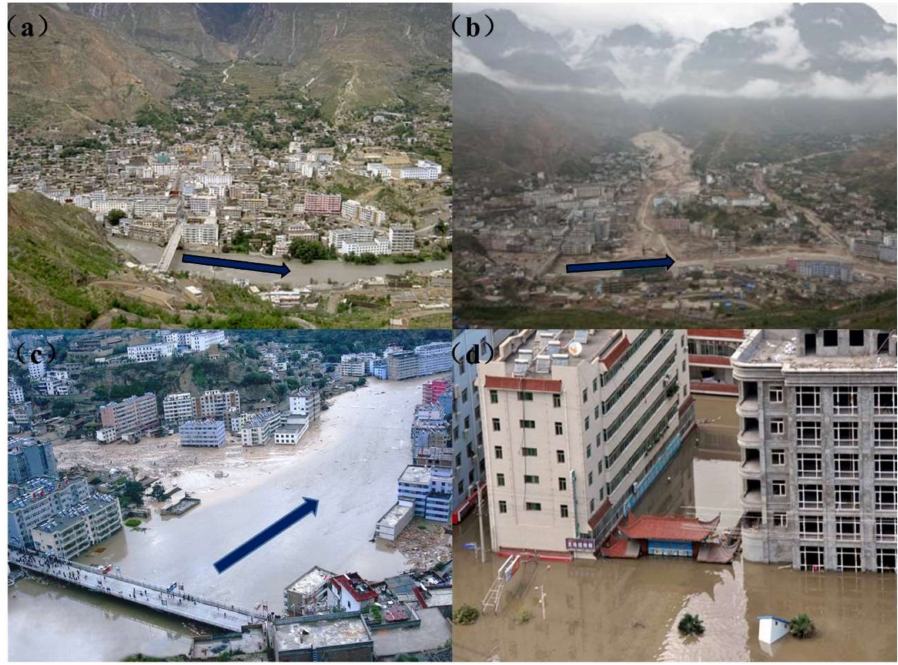
Figure 2. Zhouqu “8.8” debris flow: ( a ) before the disaster, ( b ) after the disaster, ( c ) and ( d ) flood scenes of Zhouqu (photograph credit: